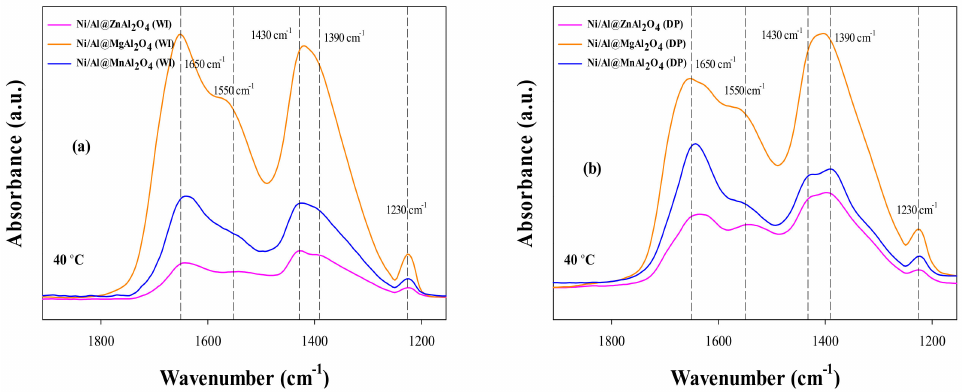
Figure 2. In-situ di ff use reflectance infrared Fourier transform spectroscopy (DRIFT) spectra for CO 2 adsorption at 40 ◦ C on ( a ) Ni / Al@ZnAl 2 O 4 (WI), Ni / Al@MgAl 2 O 4 (WI), and Ni / Al@MnAl 2 O 4 (WI) samples, and ( b ) Ni / Al@ZnAl 2 O 4 (DP), Ni / Al@MgAl 2 O 4 (DP), and Ni / Al@MnAl 2 O 4 (DP)